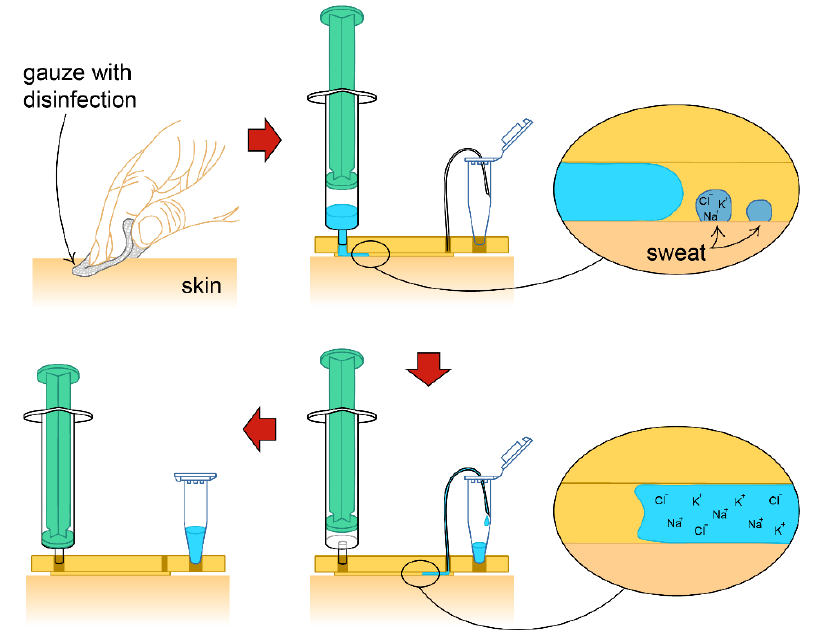
Figure 1. A schematic of the “skin-wash” procedure.